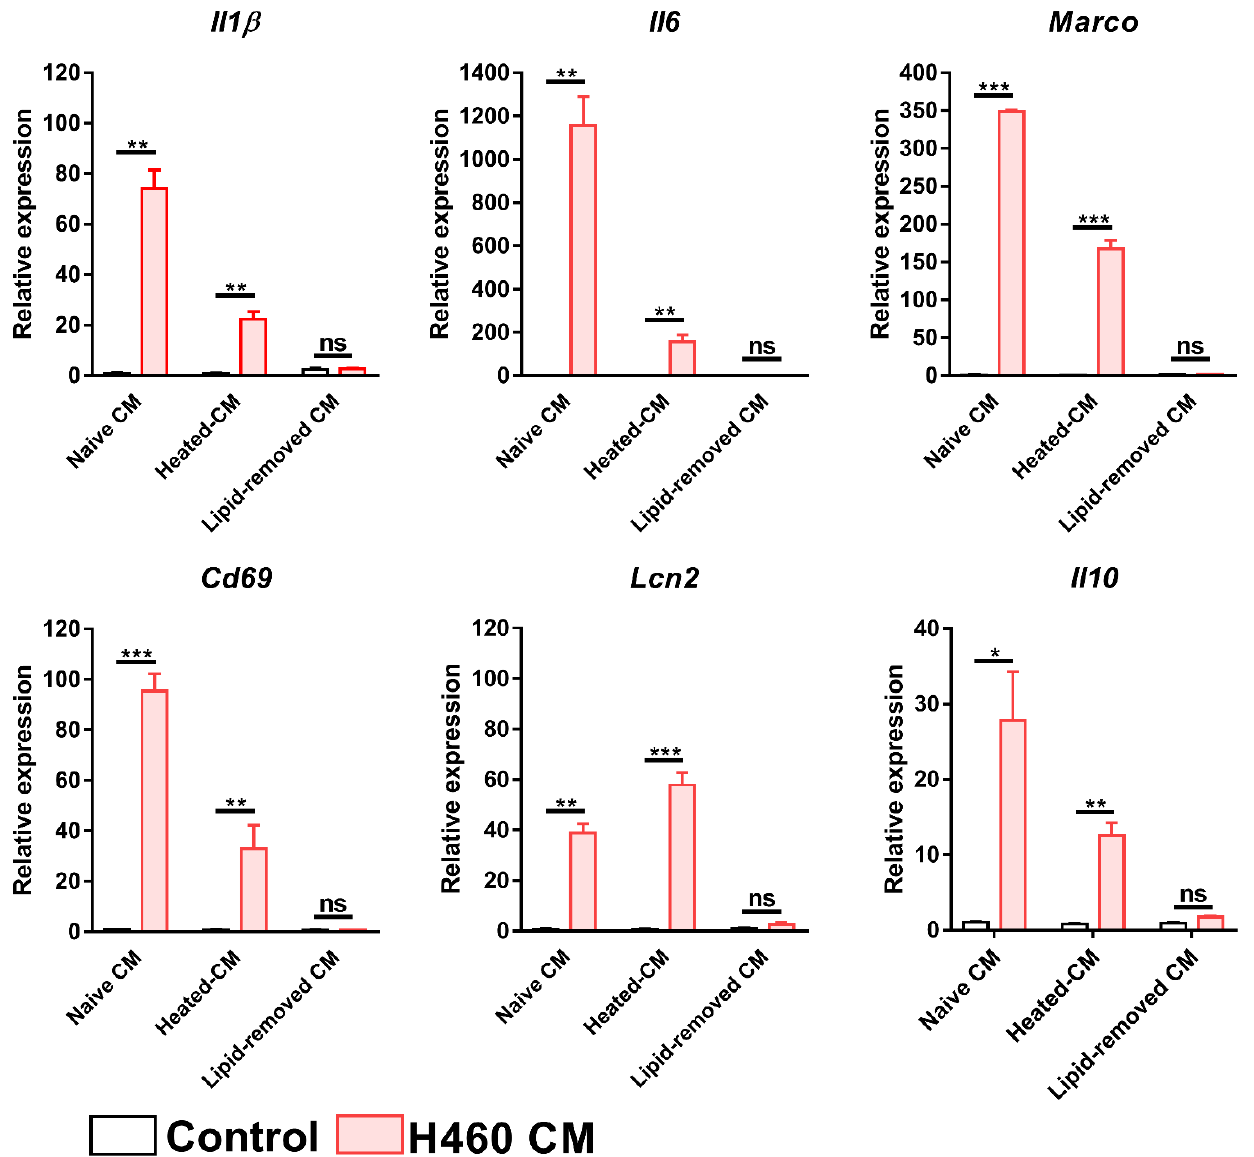
Figure 6. Effect of protein and lipid removal from H460 CM on BMDMs. mRNA level of Il1 β , Il6 , Marco , Cd69 , Lcn2 and Il10 genes, as determined by Real-Time PCR, after BMDMs exposure to H460 heated-CMs or lipid removed-CMs. Data were normalized to the housekeeping gene expression level ( β 2m ) and analyzed by the comparative 2 − ΔΔ Ct method. Data are presented as the mean ± SEM.* p < 0.05, ** p < 0.01, *** p < 0.001 by unpaired t -test; ns: not significant.